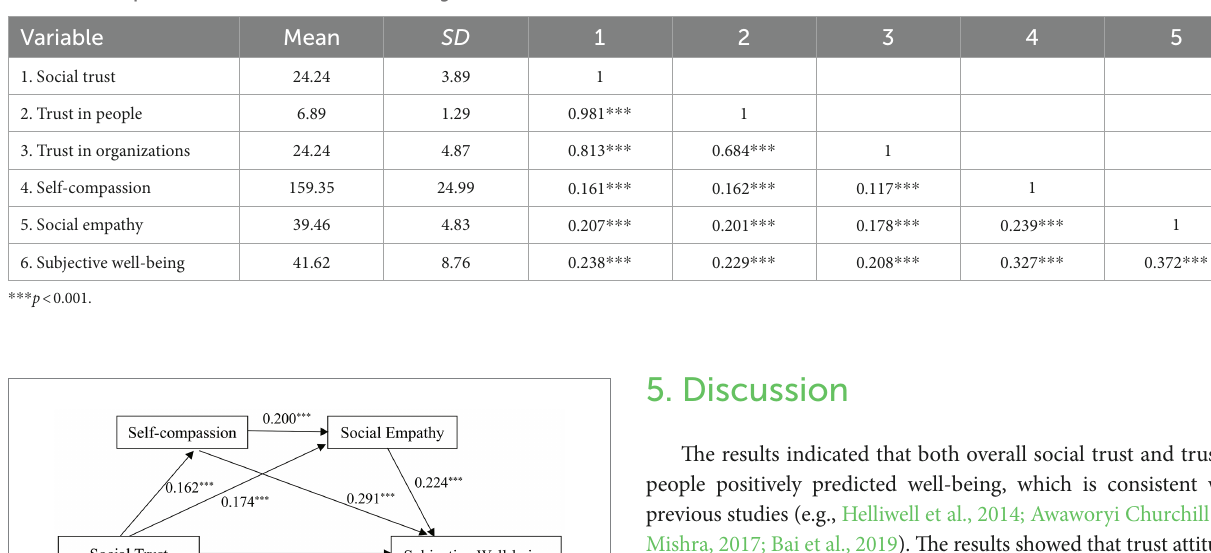
TABLE 1 Descriptive statistics and correlations among the variables.